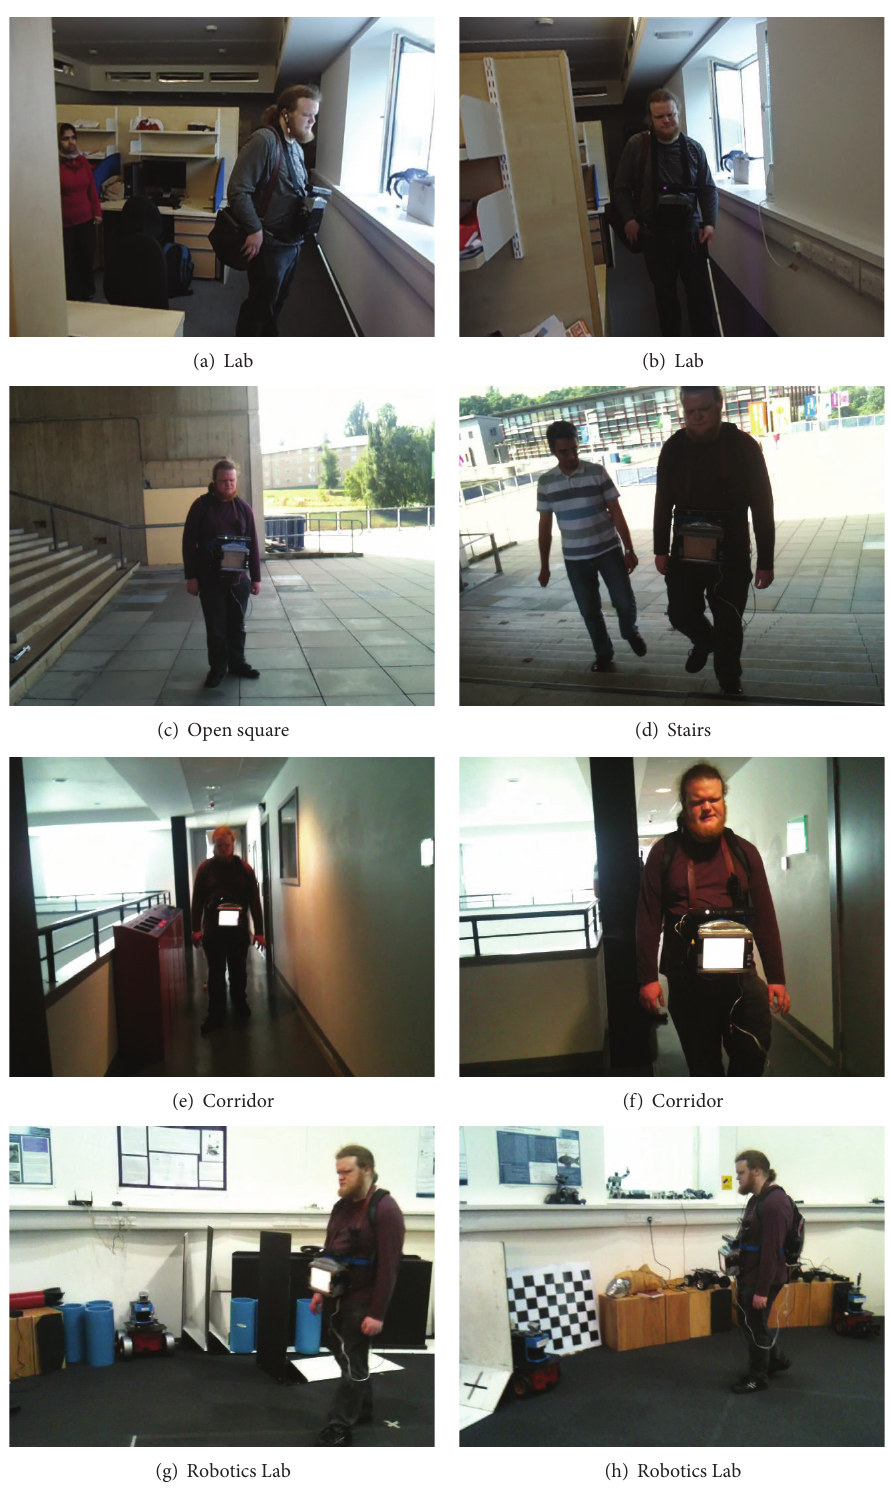
Figure 12: Keith Curie walking at different locations using Kinect-aided navigation